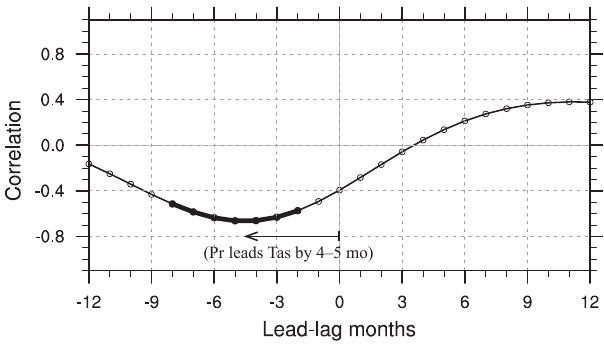
Figure 1. The cross-correlation coefficients between the tropical land precipitation (Pr) and temperature (Tas). The horizontal axis denotes the lead-lag months between precipitation and temperature, with negative values indicating that precipitation leads temperature. Bold line indicates correlation above 95% significance ( p ≤ 0 .